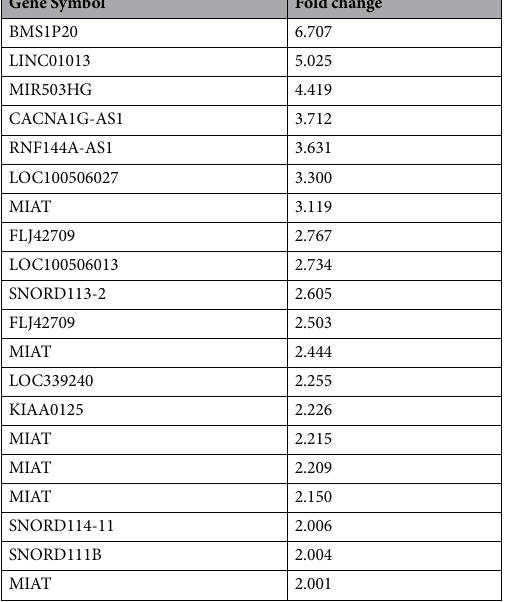
Table 1. Up-regulated lncRNAs of anaplastic large T cell lymphoma (ALK + ). T/N >